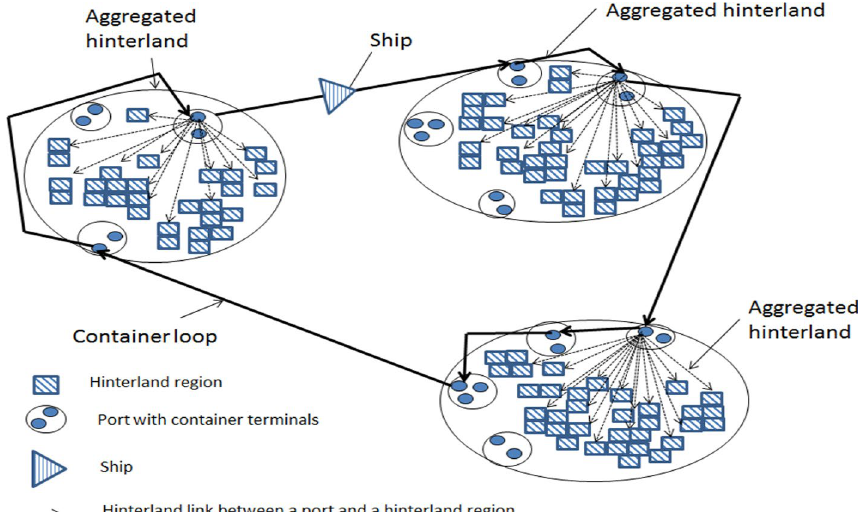
Fig. 2 General Concept of Cost Chain Model. Source: van Hassel et al. 2016a,